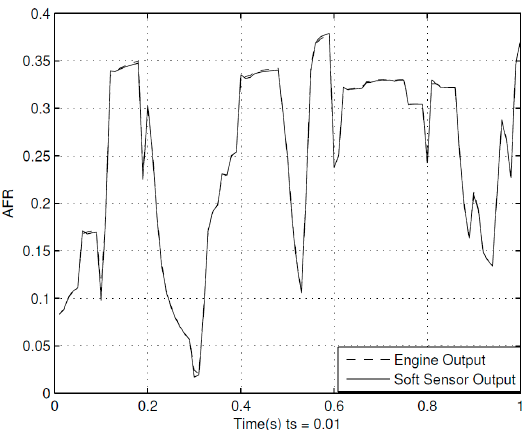
Figure 7. The performance of the AFR soft sensor by RBFN.